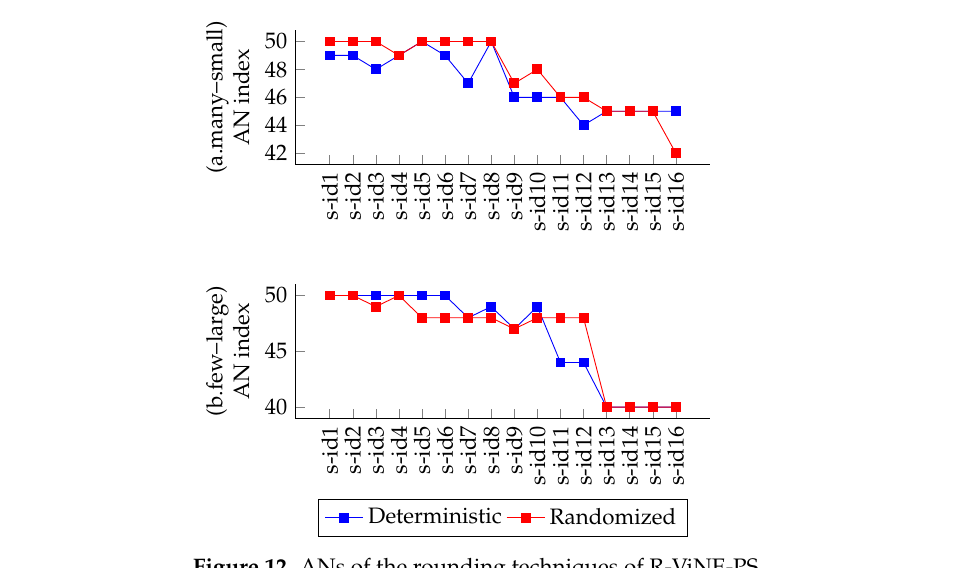
Figure 12. ANs of the rounding techniques of R-ViNE-PS.